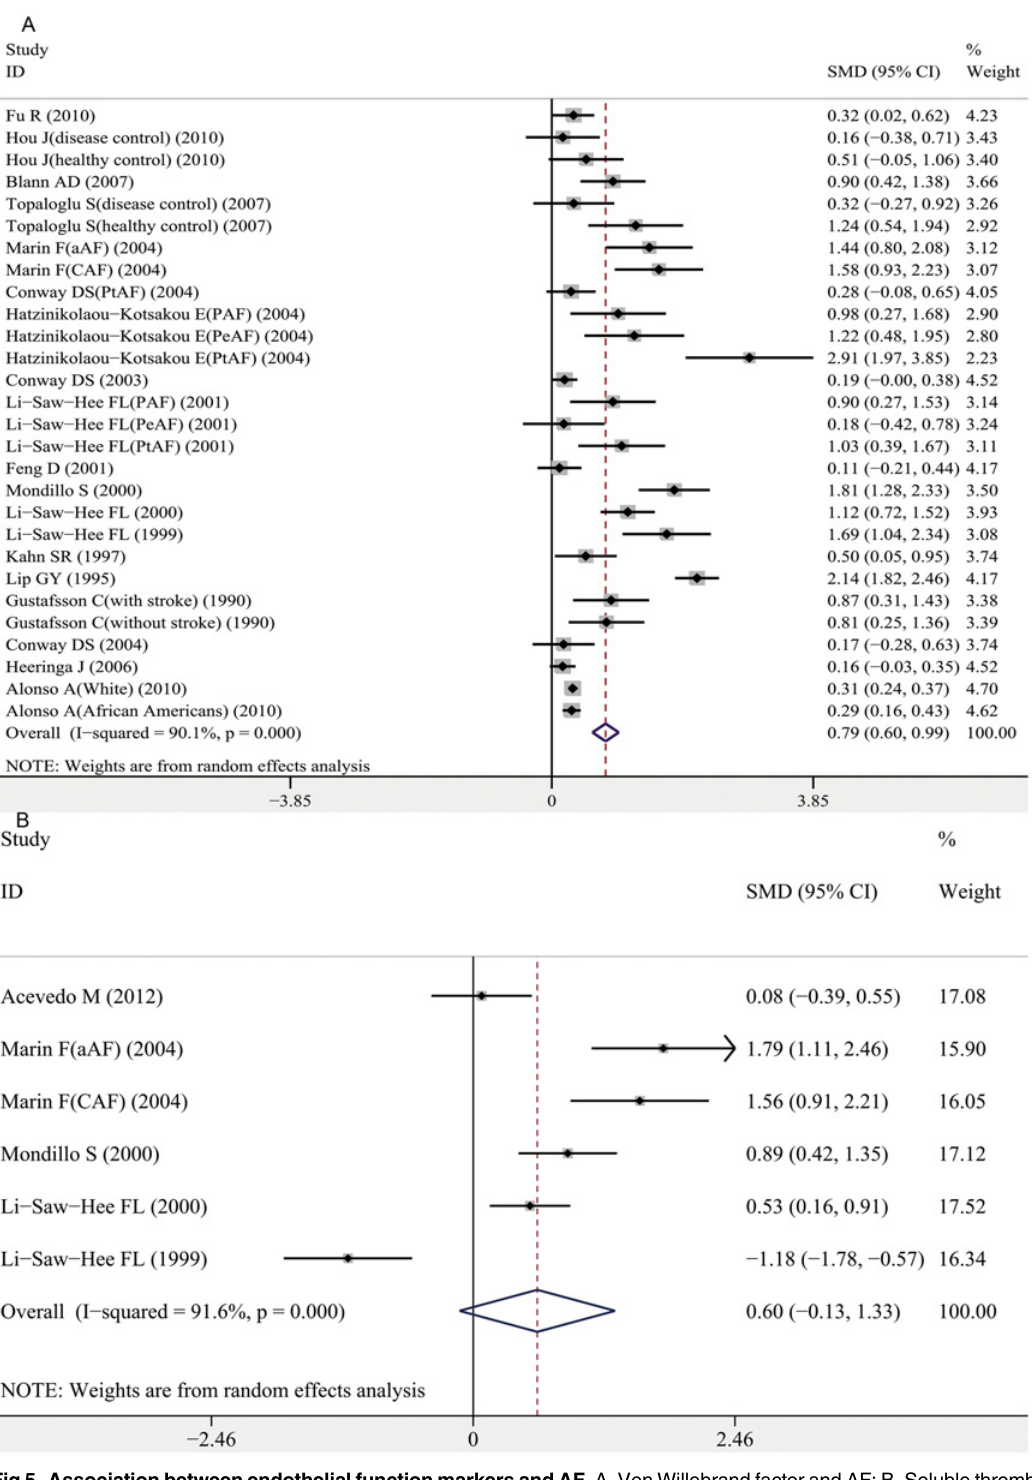
Fig 5. Association between endothelial function markers and AF. A. Von Willebrand factor and AF; B. Soluble thrombomodulin and AF. Forest plots of SMD and overall SMD with 95% CI between AF cases and controls. Black diamonds indicate the SMD, with the size of the square inversely proportional to its variance, and horizontal lines represent the 95% CI. The pooled results are indicated by the black hollow diamond. AF, atrial fibrillation; vWf, von Willebrand factor; sTM, soluble thrombomodulin; PAF, paroxysmal AF; PeAF, persistent AF; PtAF, permanent AF; CAF, chronic AF; aAF, acute AF; SMD, standardized mean